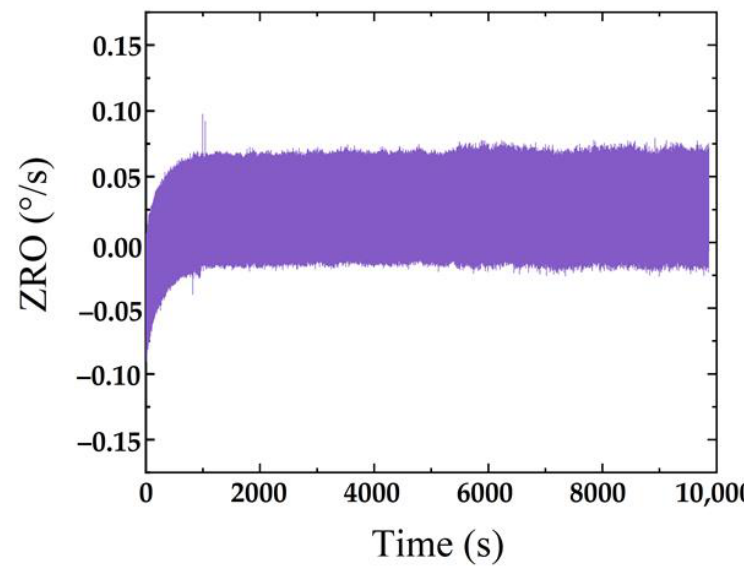
Figure 12. Room-temperature ZRO results.